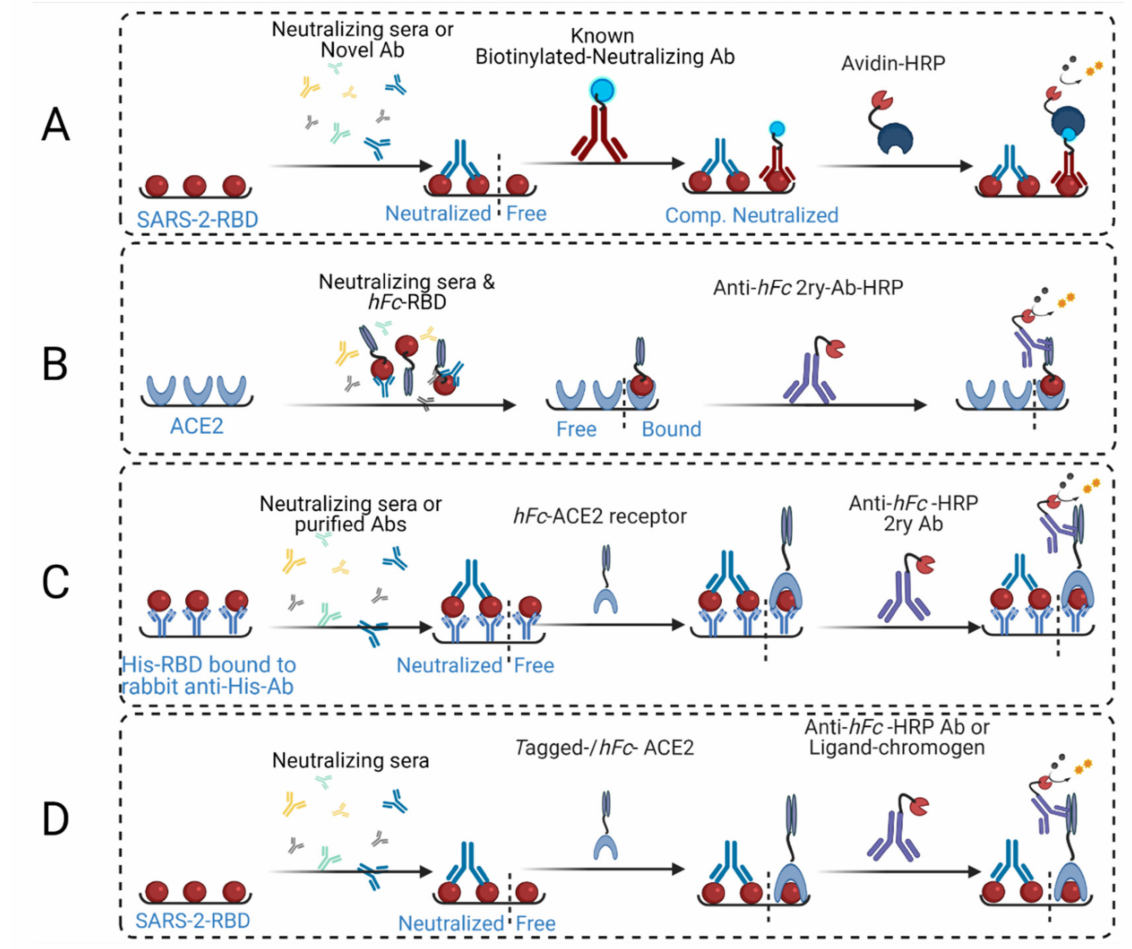
Figure 1. Schematic representation of various reported assay strategies. ( A ) This strategy involves coating ELISA plates with SARS-2-RBD, employing neutralizing sera or unknown Abs, applying known competing biotinylated neutralizing Abs, then adding chromogen-streptavidin followed by substrate for color generation and detection via plate common readers. ( B ) This strategy involves coating ELISA plates with ACE2, then employing a mixture of neutralizing sera and human IgG-Fc-RBD conjugate ( hFc -RBD), followed by anti-human IgG-Fc-HRP-conjugated secondary Abs (Anti- hFc -2 ry Ab-HRP) and substrate. ( C ) This strategy utilizes the capture ELISA principle, where anti-histidine rabbit Abs are coated onto the plates, followed by capture of the applied His-tagged RBD. Neutralizing sera or purified antibodies are applied, followed by human IgG-Fc-conjugated ACE2 ( hFc -Ace2), then anti- hFc -2 ry Ab-HRP and substrate. ( D ) Our strategy, which is reported herein, involves coating the ELISA plates with RBD, applying neutralizing sera and hFc -ACE2 (or biotin-tagged ACE2), then adding anti- hFc -2 ry Ab-HRP (or chromogen-streptavidin), respectively, with substrate for color generation and